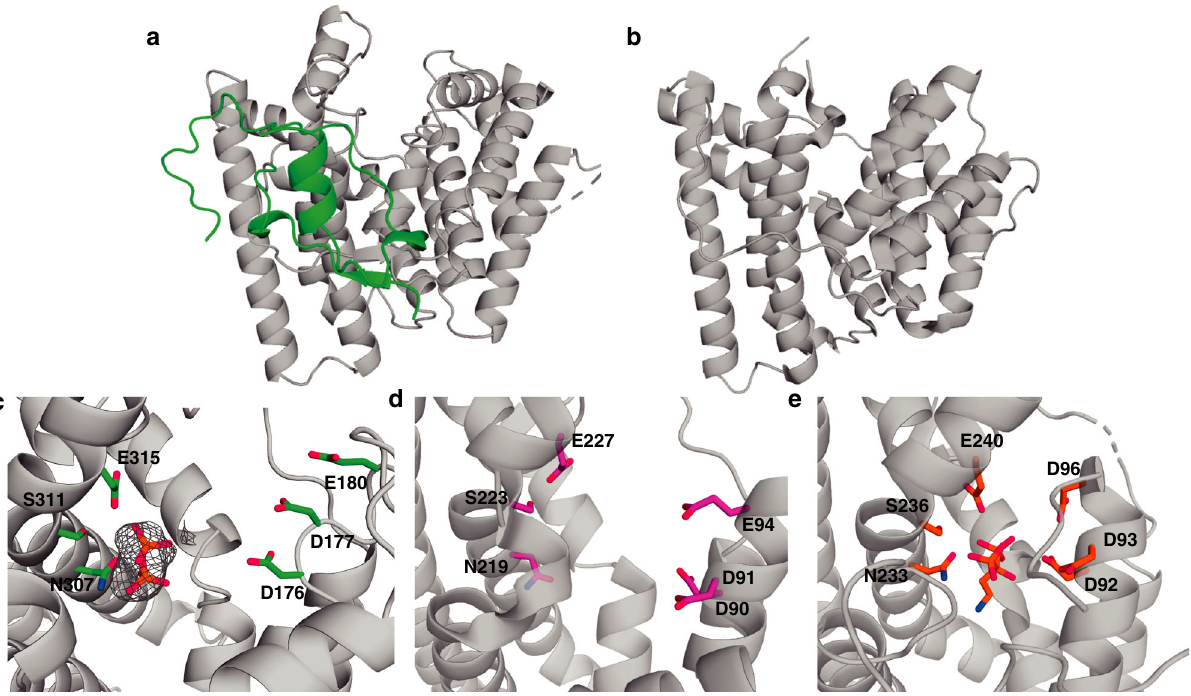
Fig. 4 Structural comparison of AaTPS and other terpene synthases. a Overall structure of AaTPS. The additional N-terminal segment is green. b Overall structure of aristolochene synthase from Aspergillus terreus (PDBID 2OA6). c – e Comparison of the DDXXD/E and NSE/DTE motifs. c Omit map of inorganic pyrophosphate in the active site of AaTPS, contoured at 4.5 σ . d Close-up view of the active site of aristolochene synthase from Aspergillus terreus (PDB 2OA6). e Active site of the cyclization domain of fusicoccadiene synthase (PDB